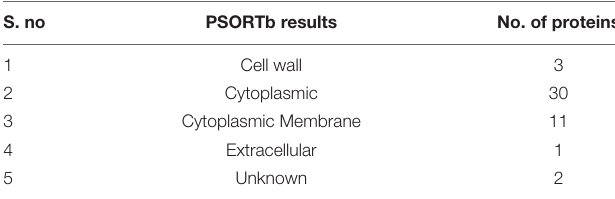
TABLE 4 | Subcellular localization: Distribution of essential non-homologous proteins in a different area of cell. S. no PSORTb results No. of